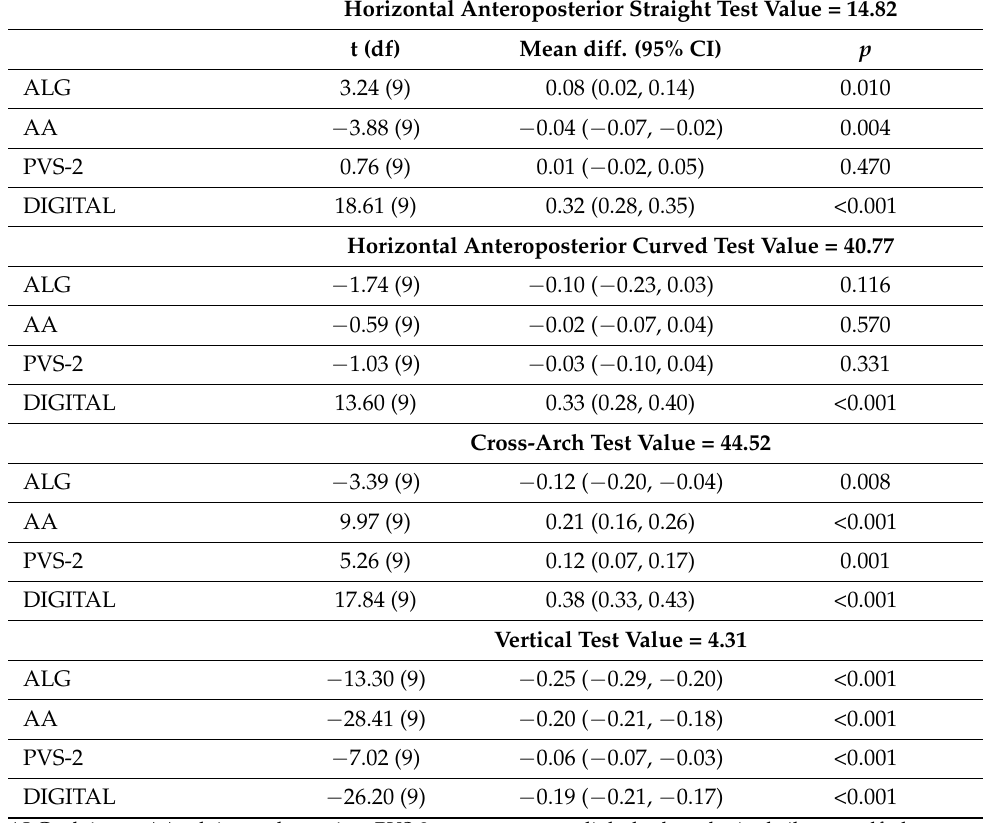
Table 2. One sample t -test results for the dispersion of measurements around the test values (typodont master cast measurements).